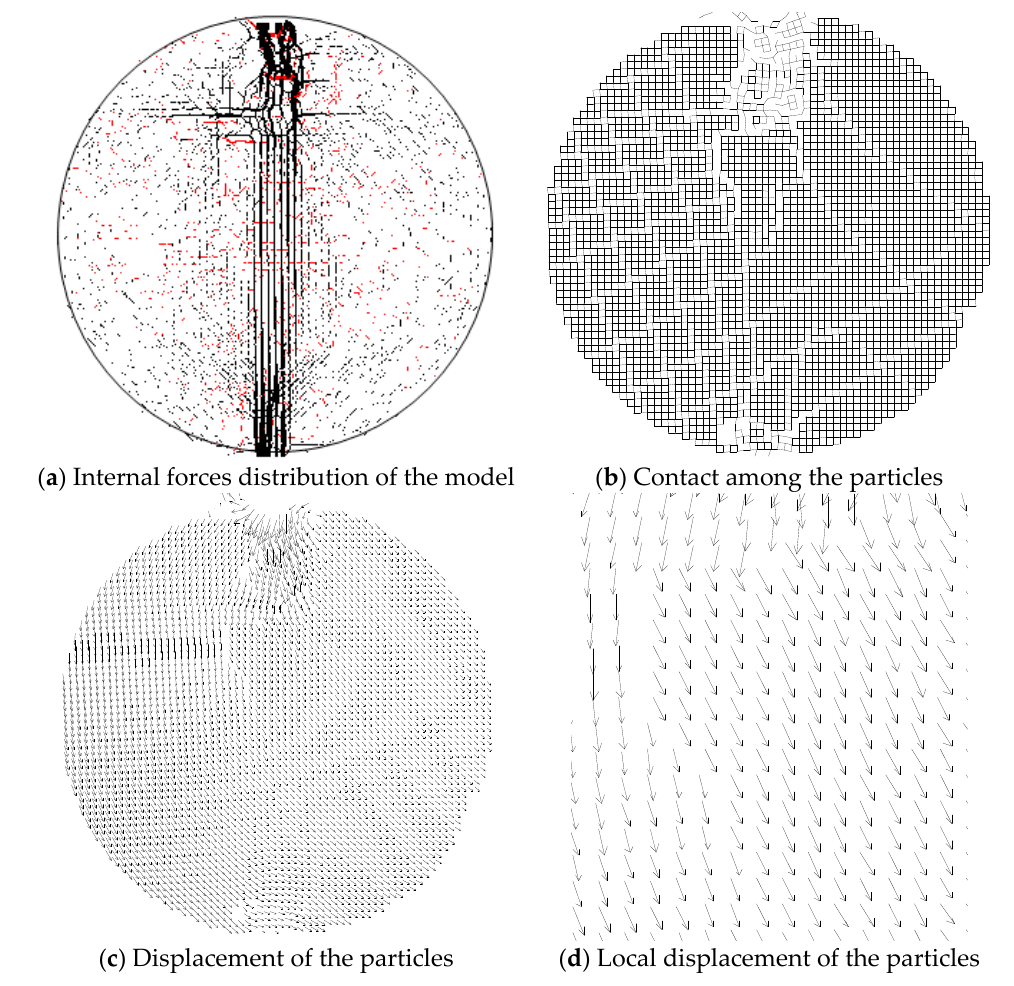
Figure 10. Crack development.